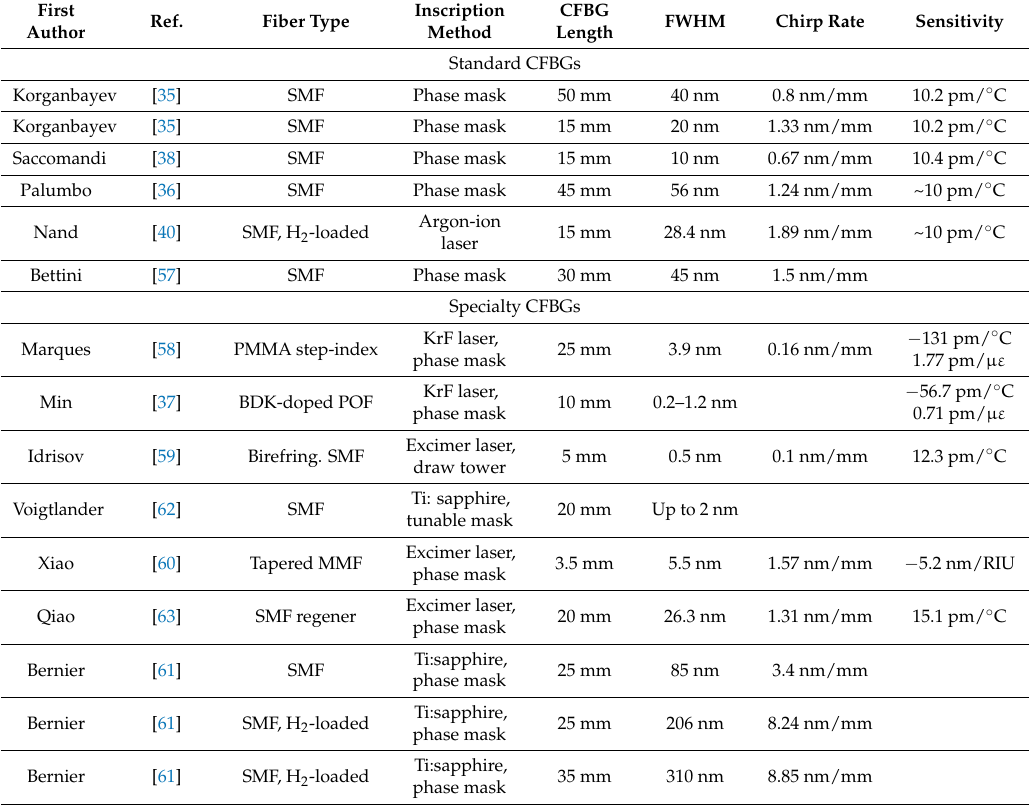
Table 1. Reports of inscription of CFBG in conventional and specialty fibers and